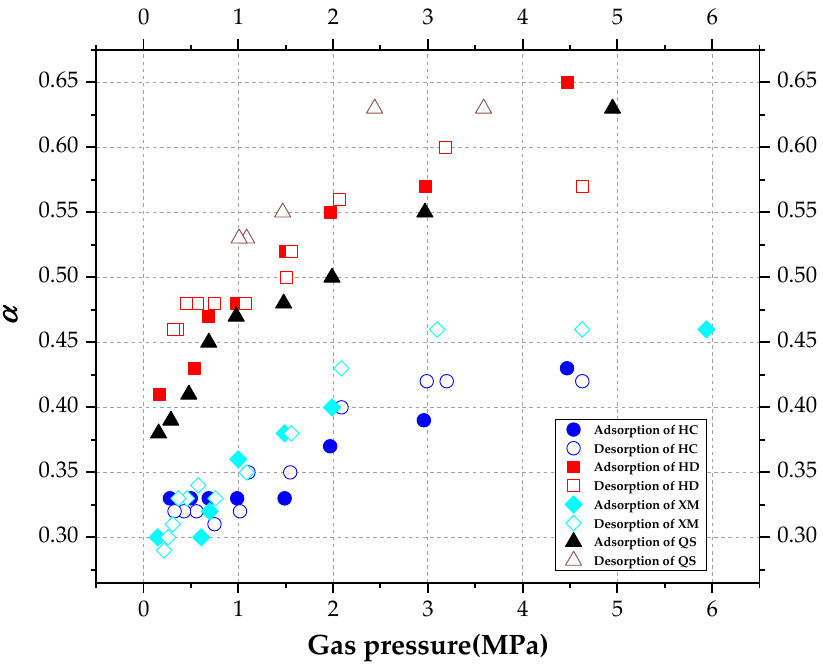
Figure 9. The diagram of variation of stretching parameter α with pressure.